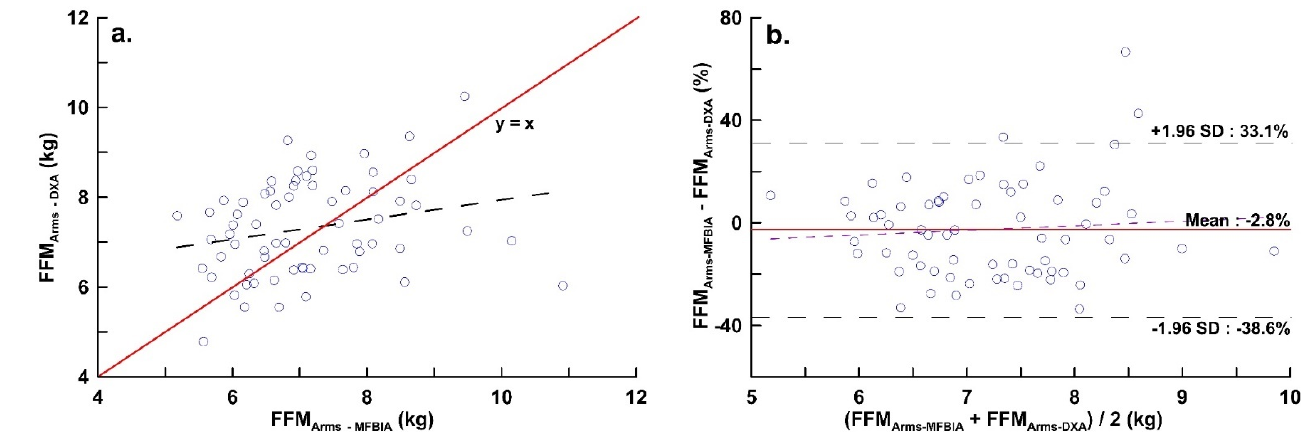
Figure 1. ( a ) Distribution of upper limbs fat-free mass measured by DXA and MF BIA (y = 5.749 + 0.219x, r = 0.237, Residual Stand Deviation = 1.043, p = 0.055); ( b ) Bland–Altman Plots of upper limbs fat-free mass measured by DXA and MF BIA (bias: − 2.755%, LOA: − 38.64% to 33.12%, y = − 14.637 + 1.644x, p = 0.530). The red line and the dotted line represent the bias and LOA respectively.